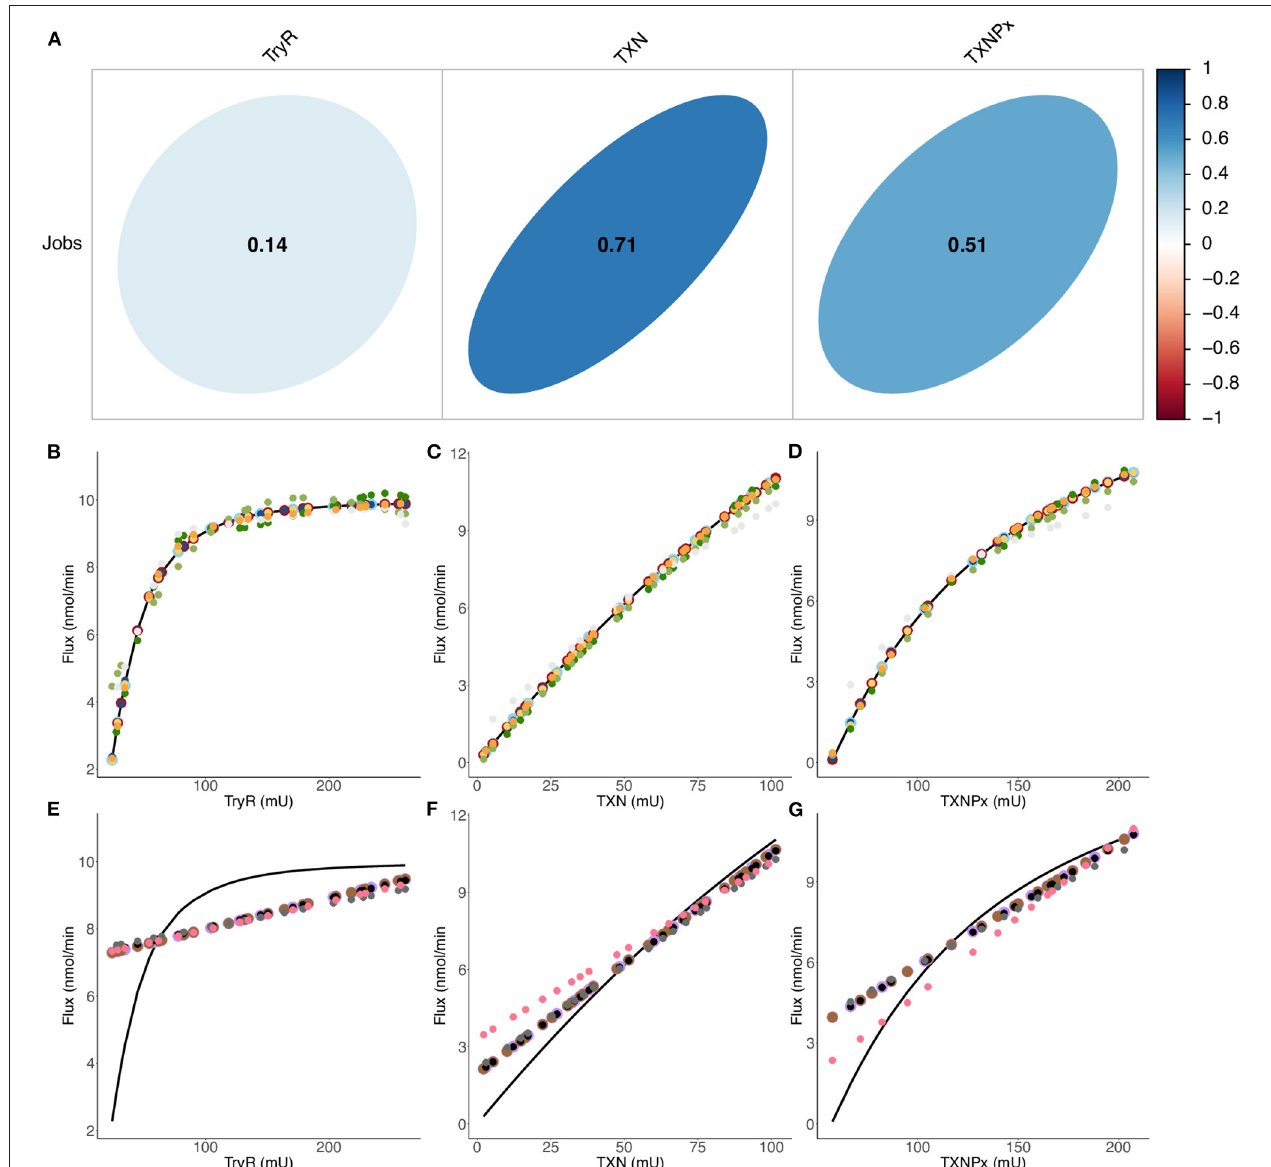
FIGURE 6 | Comparison of final flux predictions by different predictive models. (A) Linear correlation between enzyme activities (inputs) and the flux (output) of Dataset 2 ( Supplementary Table 8 ) when all enzyme activities are varied. Correlation coefficients are also calculated when only one enzyme activity is varied: 0.76 (TryR), 0.998 (TXN) and 0.97 (TXNPx). A perfect circle means that there is no linear correlation between the variables, while a straight line means that there is a perfect linear correlation between the variables. (B–G) Flux variation as a function of the enzymatic activity of TryR (B, E) , TXN (C, F) and TXNPx (D, G) . Colored circles refer to predicted data from: QRF (dark blue), XGBoost Linear (light blue), Cubist (red), Rborist (yellow), ANN (orange), bagEarth GCV (light gray), SVM Poly (light green), SVM Radial (dark green), Bayesian GLM (purple), Spike-and-slab (brown), Ridge (black), Lasso (dark gray) and PLS (pink). A curve of the fitting experimental data is represented by the black curve. See Table 3 for the statistical measurements of each